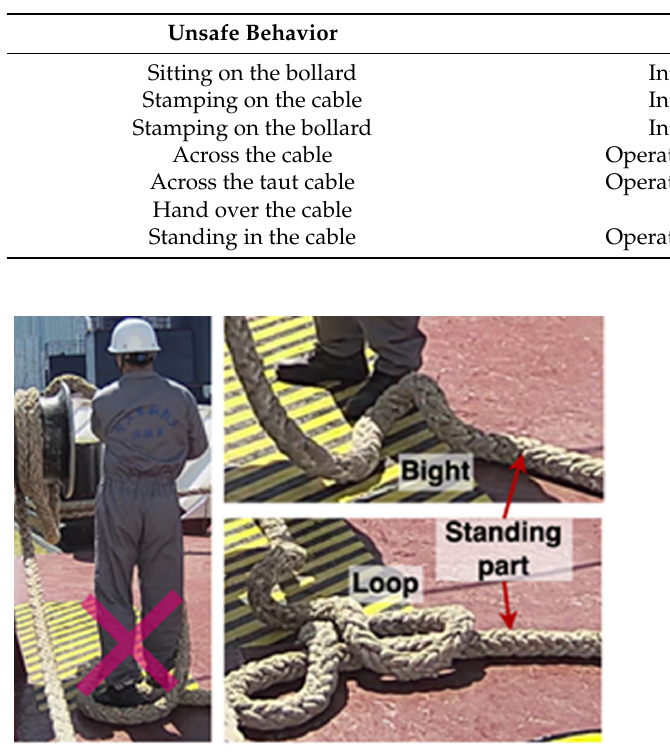
Figure 2. Unsafe behavior of standing in a loop or “bight” of any rope.